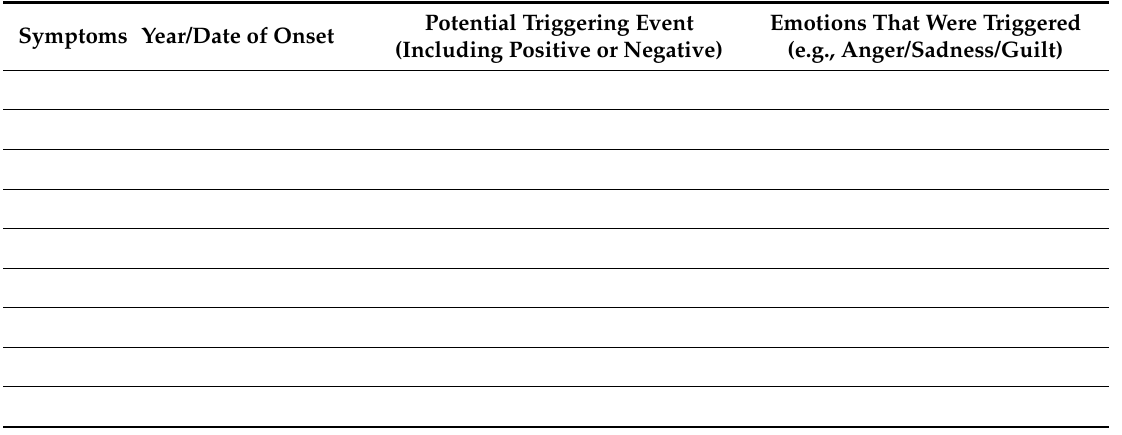
Figure A3. Patient Information Sheet (2).